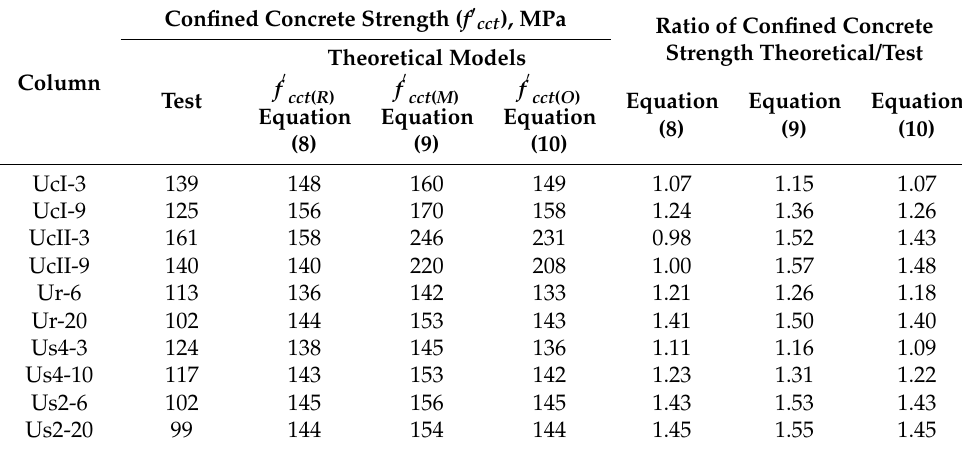
Table 5. Validation of analytical models for confined concrete strength.